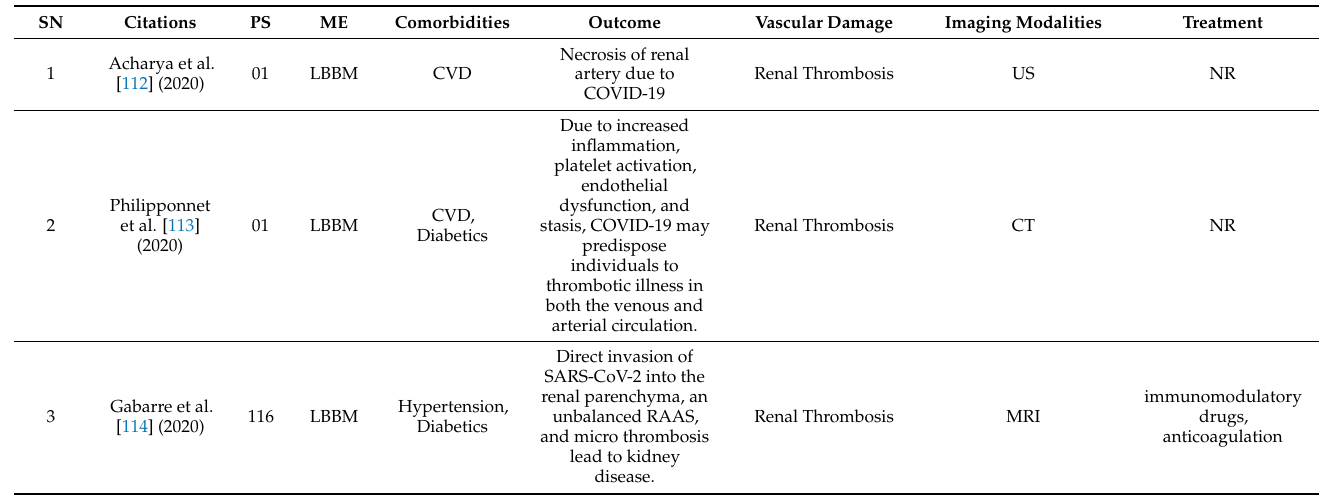
Table 2. The effect of COVID-19 on renal